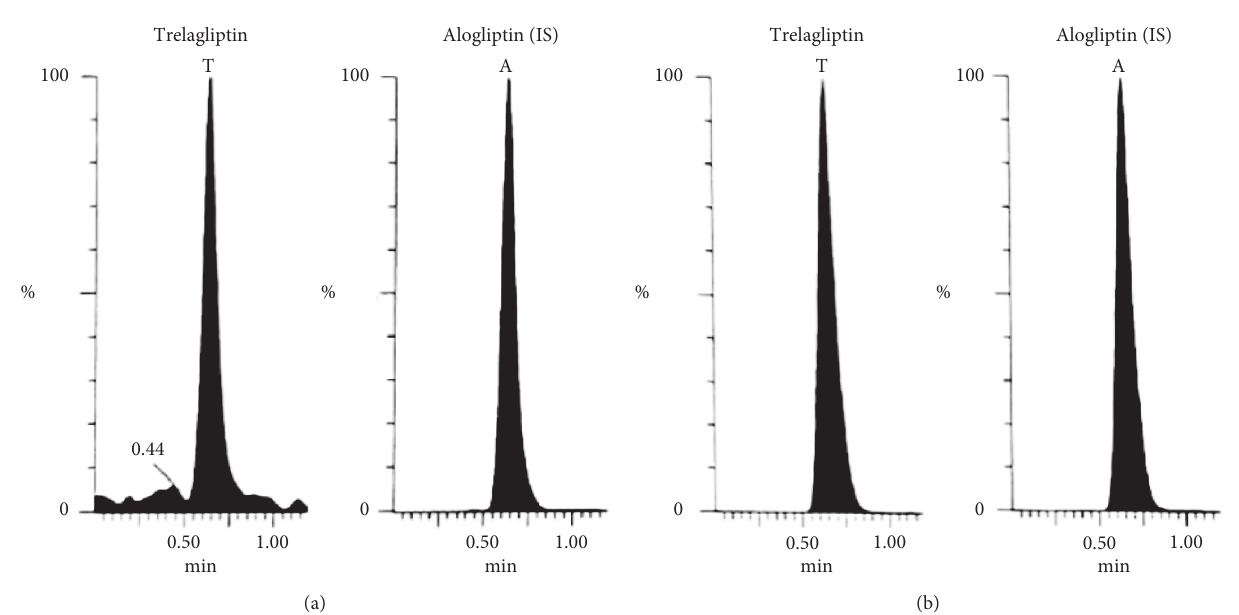
Figure 9: MRM of TLN (m/z � 358.2 to 133.9) and (IS, m/z � 340.2 to 116.0) in the human volunteer plasma sample obtained after (a) 5 days (close to C min ) and (b) after 1hr (close to C max ) of TLN (50 mg).